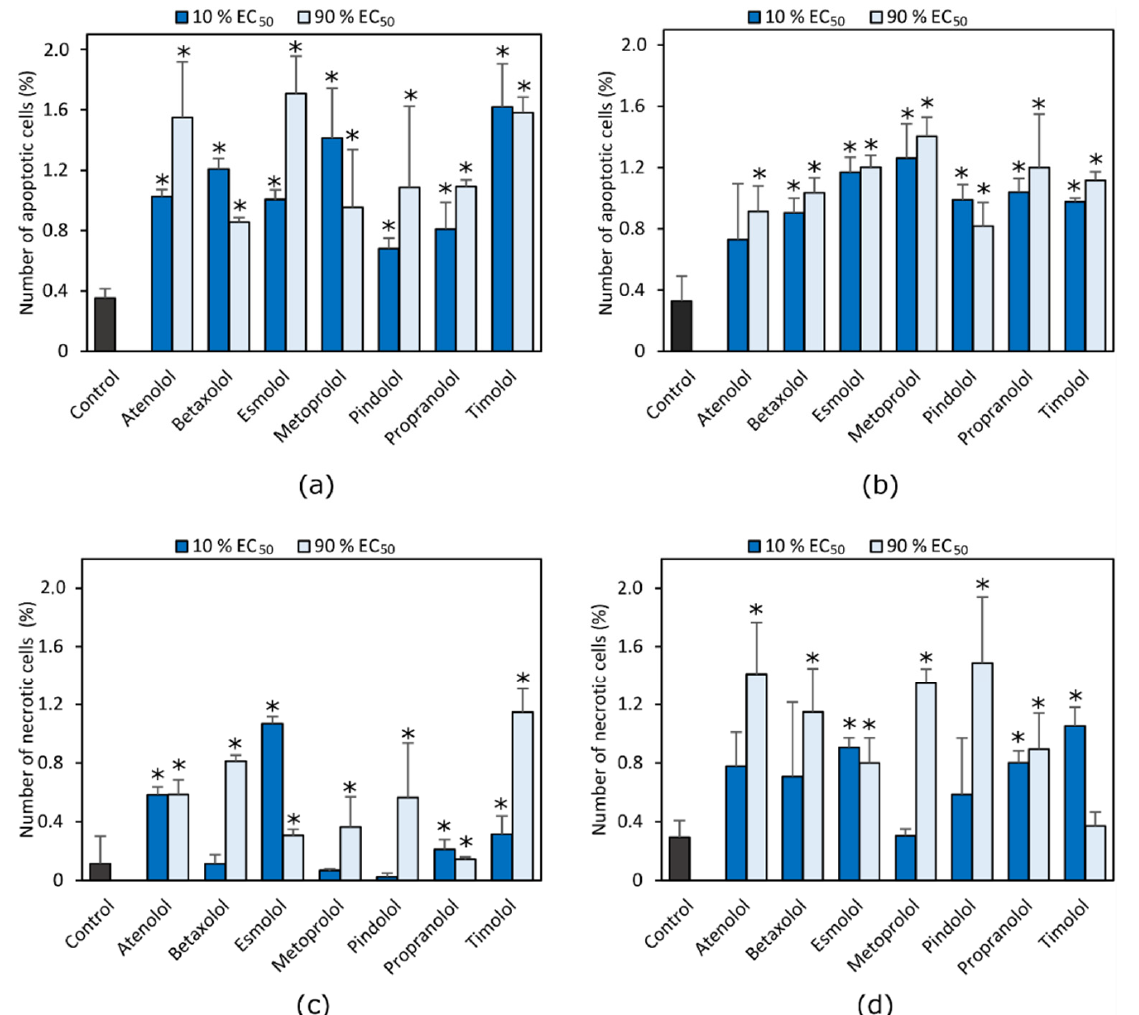
Figure 4. The effect of beta adrenoblockers on NCLSC cell death type. Number of apoptotic cells in ( a ) A549; ( b ) H1299 cancer cell lines and number of necrotic cells in ( c ) A549 and ( d ) H1299 cell lines. * p < 0.05, compared to the control.